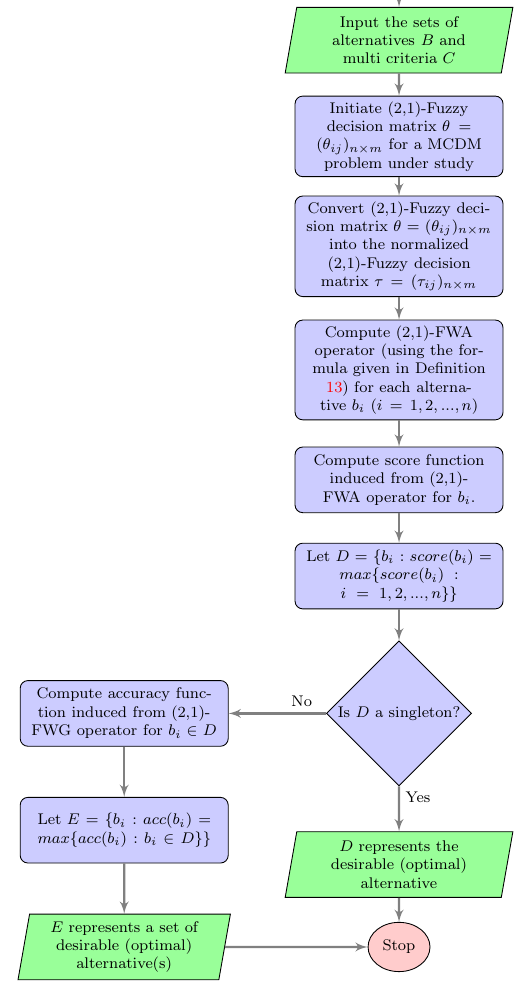
Fig.3 Flow chart of selection the optimal alternative(s) with respect to (2,1)-FWA operator